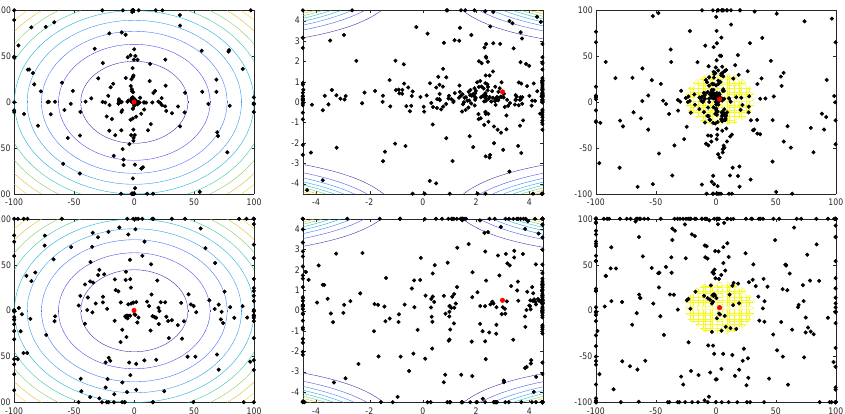
Figure 2. Search maps of search agents when solving functions f 1 , f 3 , and f 4 ; by the ESCA algorithm ( first row ); and the SCA algorithm ( second row